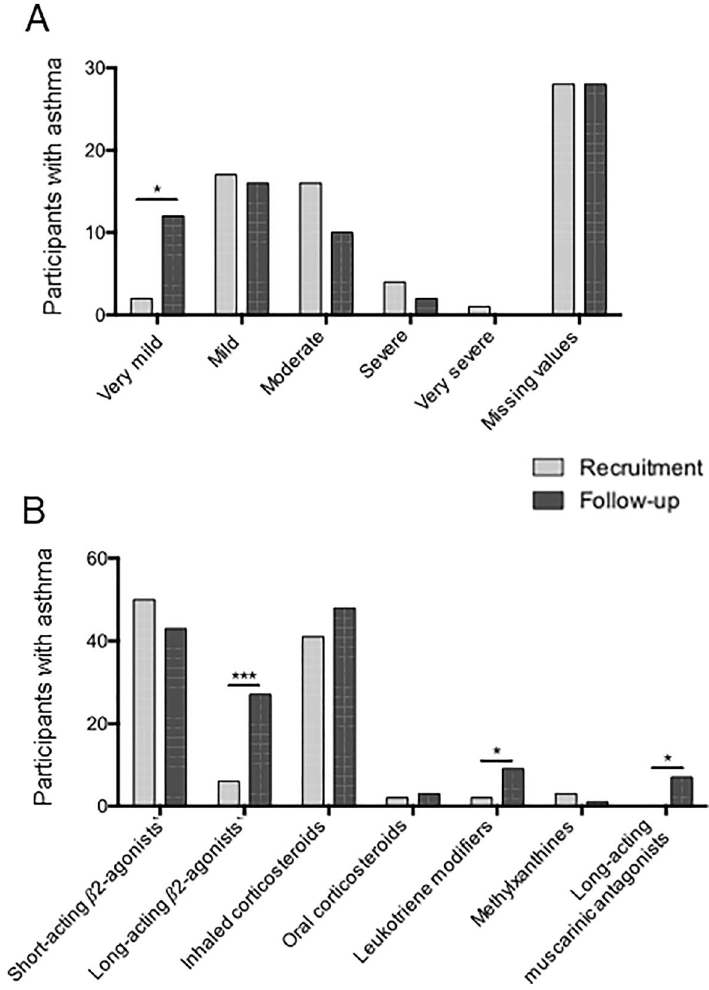
Figure 2. Asthma severity over time. ( A ) Participants classified the severity of their disease using a self- reported questionnaire. ( B ) The use of prescription medication for asthma control evolved between recruitment and follow-up. p values < 0.05 are indicated by an asterisk and p values < 0.0001 are indicated by three